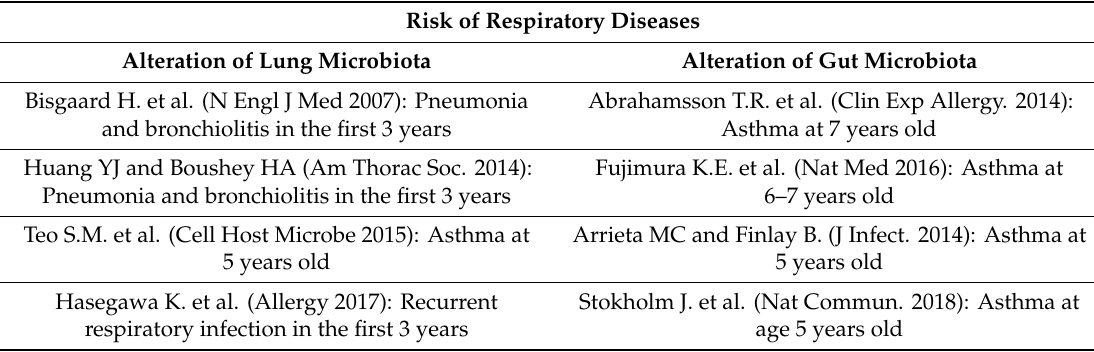
Table 3. References about the respiratory health risk in early years related to the lung and gut